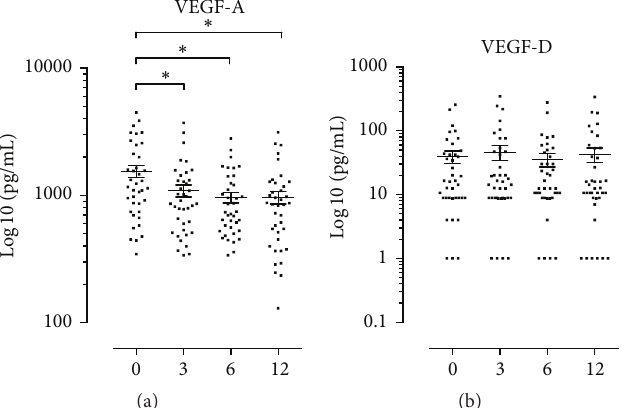
Figure 5: The VEGF-A and VEGF-D serum concentrations. The 𝑥 -axes illustrate the four assessment months after infliximab treatment is initiated. The 𝑦 -axes represent the concentrations in serum of their respective VEGF in picograms per millilitre (pg/mL) on a log 10 scale. The horizontal lines in the dot plot illustrate the mean, and the vertical error lines represent ± standard error mean (SEM) in a paired 𝑡 -test.